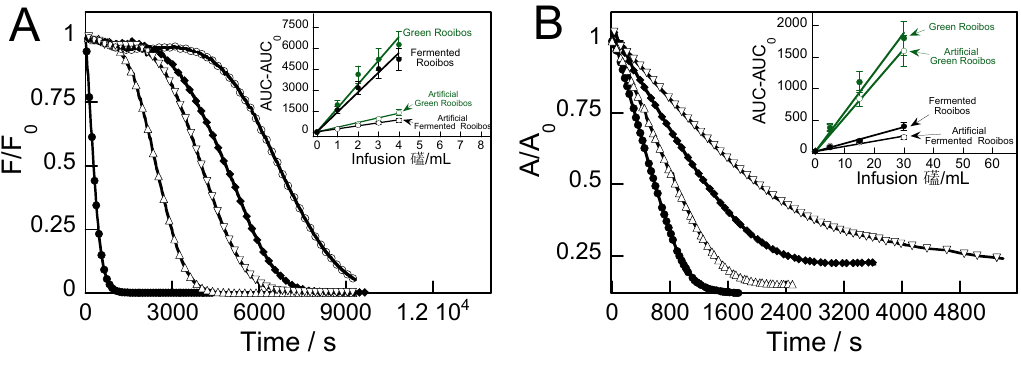
Figure 2. Effect of green rooibos infusion on fluorescein decay (A) or pyrogallol red bleaching (B) promoted by 10 mM AAPH thermal decomposition. Symbols correspond to artificial rooibos infusions (volume) as A: (  ) control, (  ) 1.0 µL/mL; (  ) 2.0 µL/mL; (  ) 3.0 µL/mL, and 4.0 µL/mL (  ); B: (  ) control, (  ) 5.0 µL/mL; (  ) 15 µL/mL, and (  ) 30 µL/mL. Insets: Area under the curve dependence for natural or